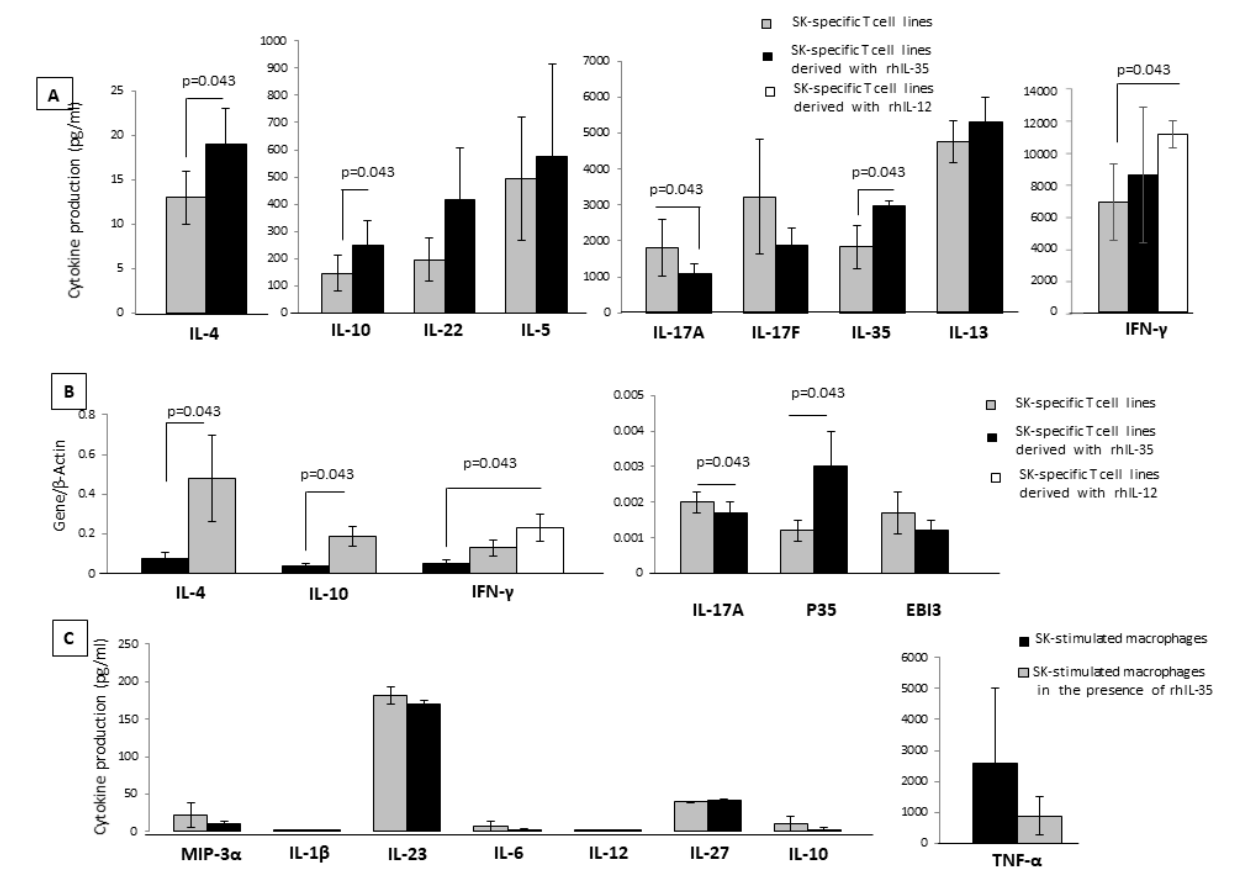
Figure 1. Effect of rhIL-35 on the cytokine production and on the cytokine mRNA expression of SK-specific T-cell lines and on the cytokine profile of macrophages. PBMCs from 10 different donors were stimulated with SK in the absence or presence of rhIL-35 at 300 pg/mL. ( A ) The levels of IL-4, IL-13, IL-10, IL-22, IL-17A, IL-17F, IL-35, and IL-5 in response to PMA plus anti-CD3 mAb in the T-cell lines specific for SK generated in the presence and absence of rh IL-35 (300 pg/mL) were measured with a multiplex bead-based assay. ( B ) T-cell lines specific for SK generated in the presence or absence of rhIL-35 (300 pg/mL) in bulk PBMC cultures were also analyzed with RT-PCR for the ability to express mRNA for IFN- γ , IL-4, IL-10, IL-17A, p35, and EBI3 in response to PMA plus anti-CD3 mAb. ( C ) Purified macrophages from PBMC obtained from five healthy donors stimulated for 5 days with the antigen SK in the absence or in the presence of rh IL-35 (300 pg/mL). MIP-3 α , IL-1 β , IL-23, IL-6, IL-12, IL-27, IL-10, and TNF- α were measured in the supernatants of macrophages with a multiplex bead-based assay.